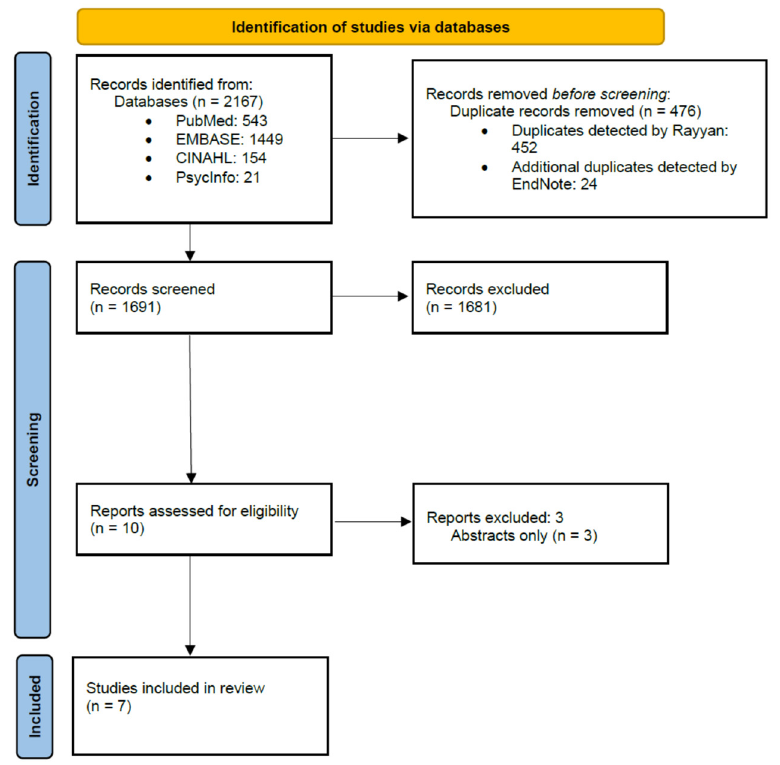
Figure 1. PRISMA Flow Diagram.